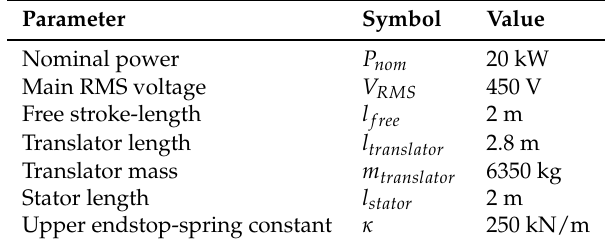
Table 1. Generator specifications for the L10 generator, at rated speed 0.7 m/s.